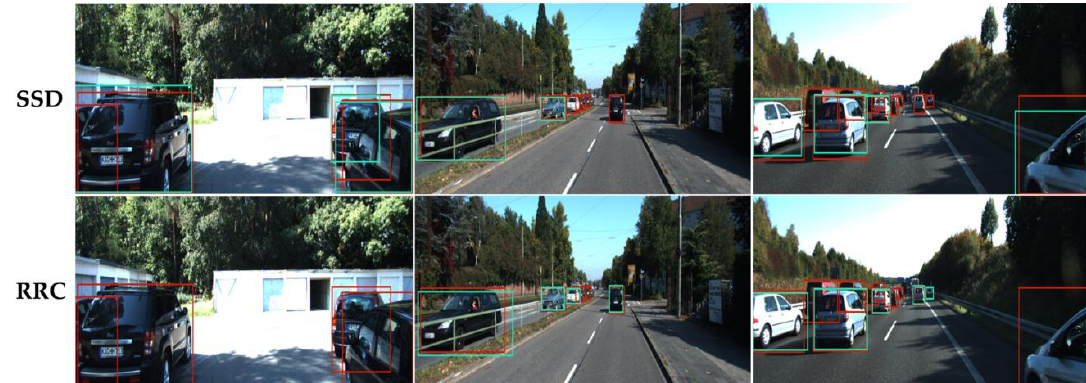
Figure 2. Visual comparisons of ground truth objects (red) and detected objects (green) produced by different object detectors. The first row shows ground truth objects and detections of SSD detector [15] on samples in KITTI Benchmark [14], and the second row shows ground truth objects and detections of RRC detector [2] on the same samples. It can be observed that FN objects missed in the same samples are different for the two detectors.